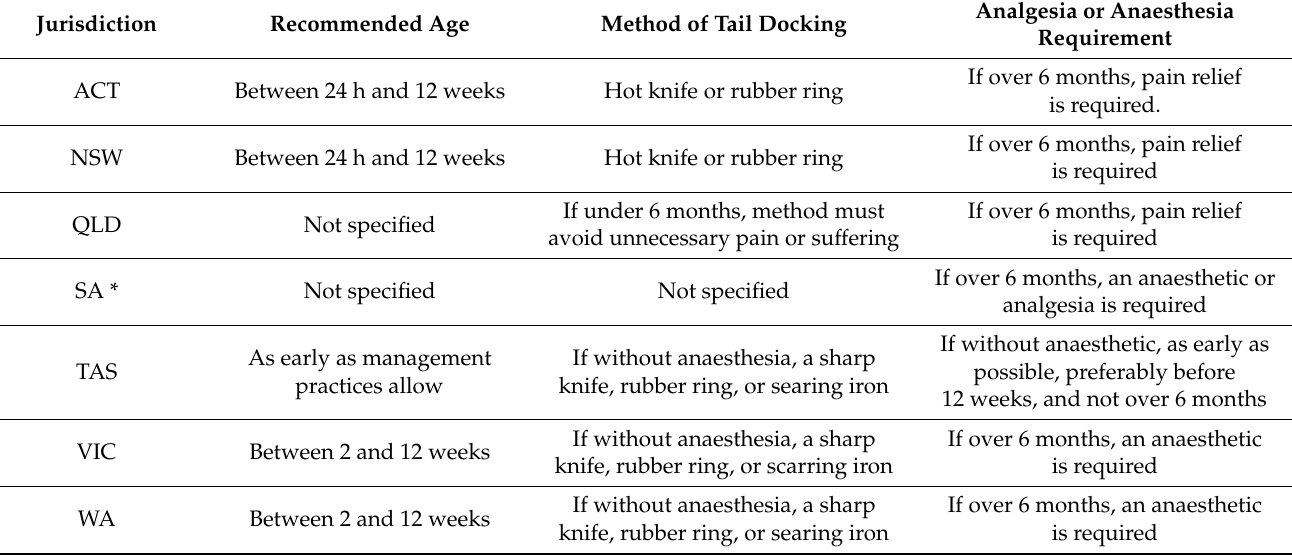
Table 2. Comparison of the recommended age, method, and pain relief for tail docking in sheep according to each jurisdiction’s code of practice for the welfare of sheep. * Noting that the detail is in the regulations in SA.